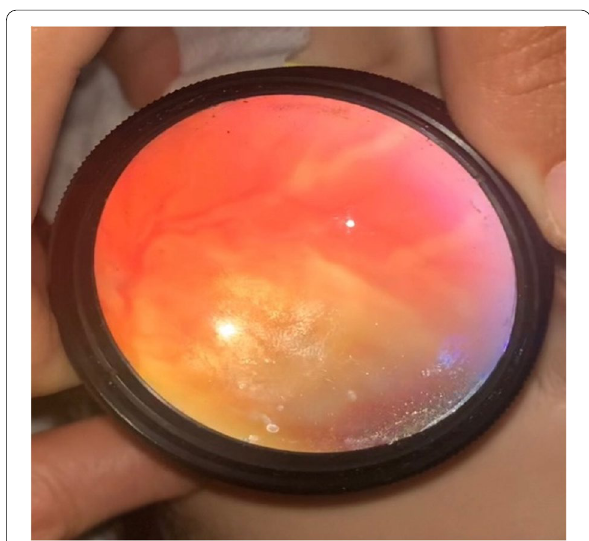
Fig. 1 Bedside indirect Ophthalmoscopy of the left eye showing exudative retinal detachment. Image has been inverted to focus on the superior arcade